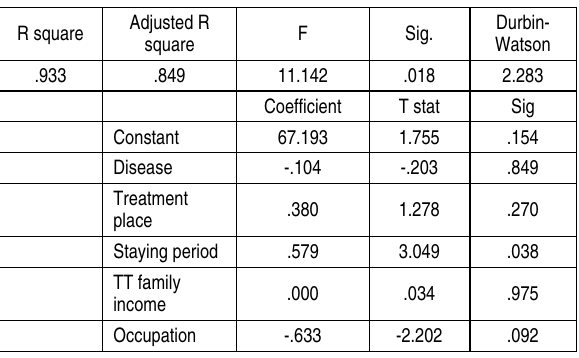
Table 1. Regression equation 1, dependent variable: